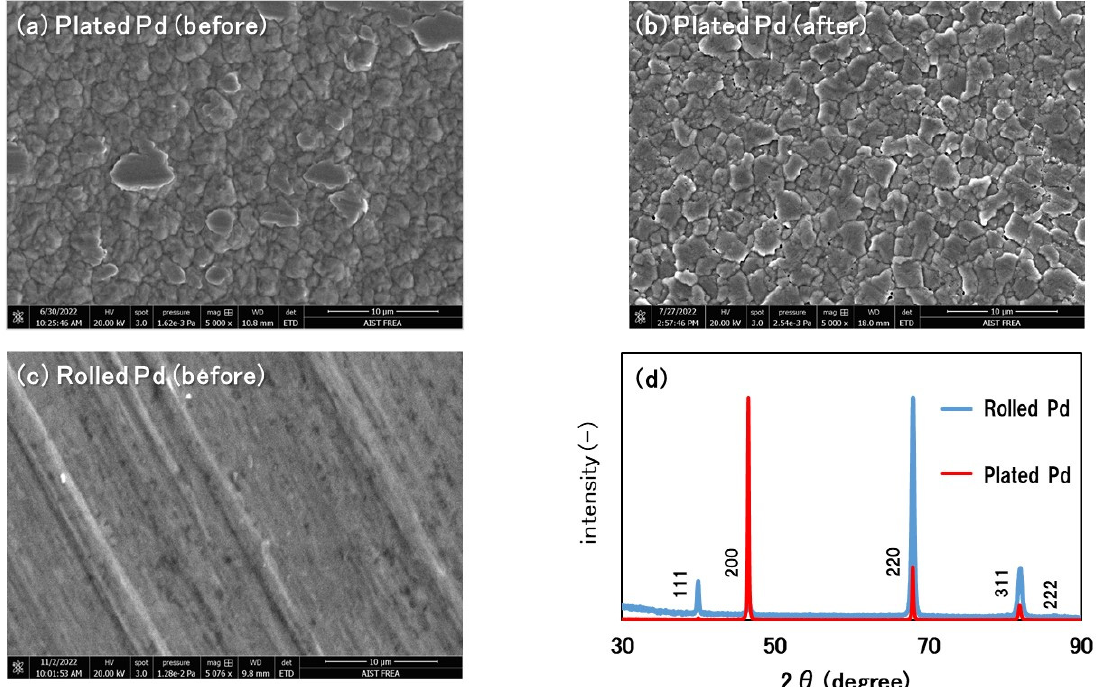
Figure 2. SEM images of the surfaces of the pure-Pd-plated film ( a ) before and ( b ) after the hydrogen-permeation tests; ( c ) rolled film. ( a , c ) Depiction of the as-plated and as-rolled states. ( d ) XRD profiles of the plated (red line) and rolled (blue line) Pd films before the hydrogen-permeation tests. Both samples had different peak intensities due to grain orientation, but they had the same FCC structure.